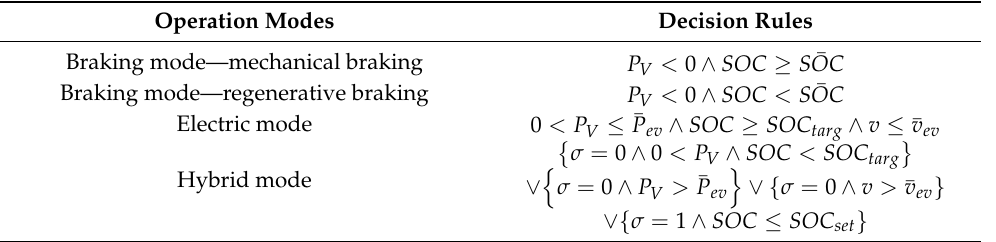
Table 1. Power-split HEV operation modes.